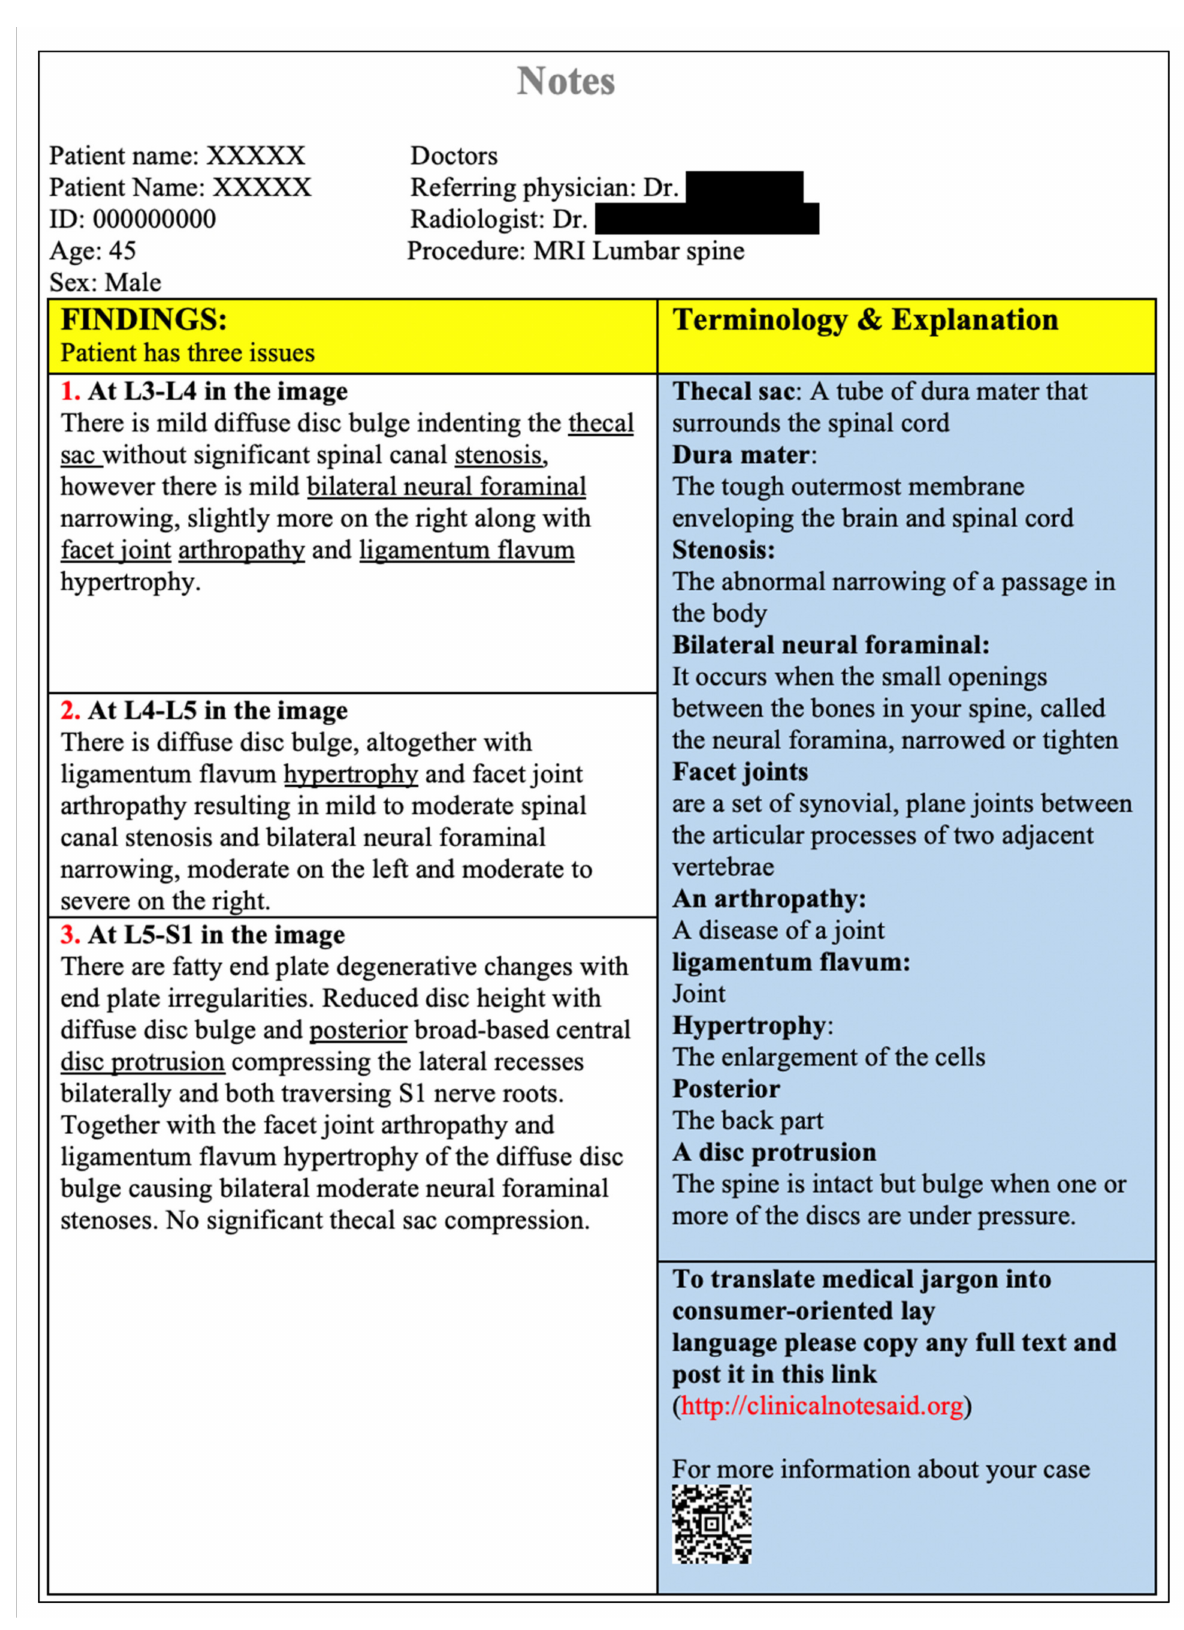
Figure 4. Revised design of the MRI lumbar spine